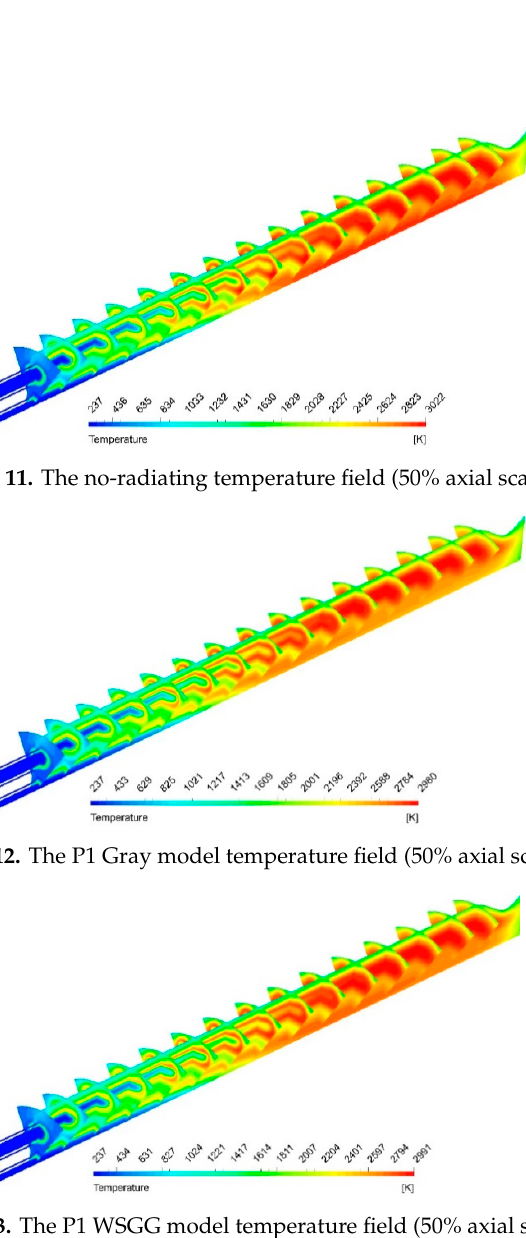
Figure 13. The P1 WSGG model temperature field (50% axial scaling).